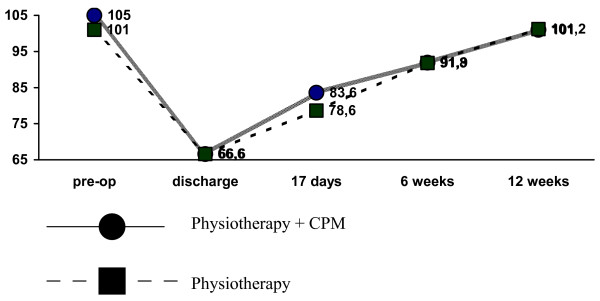
Progress of active RoM through the trial period.